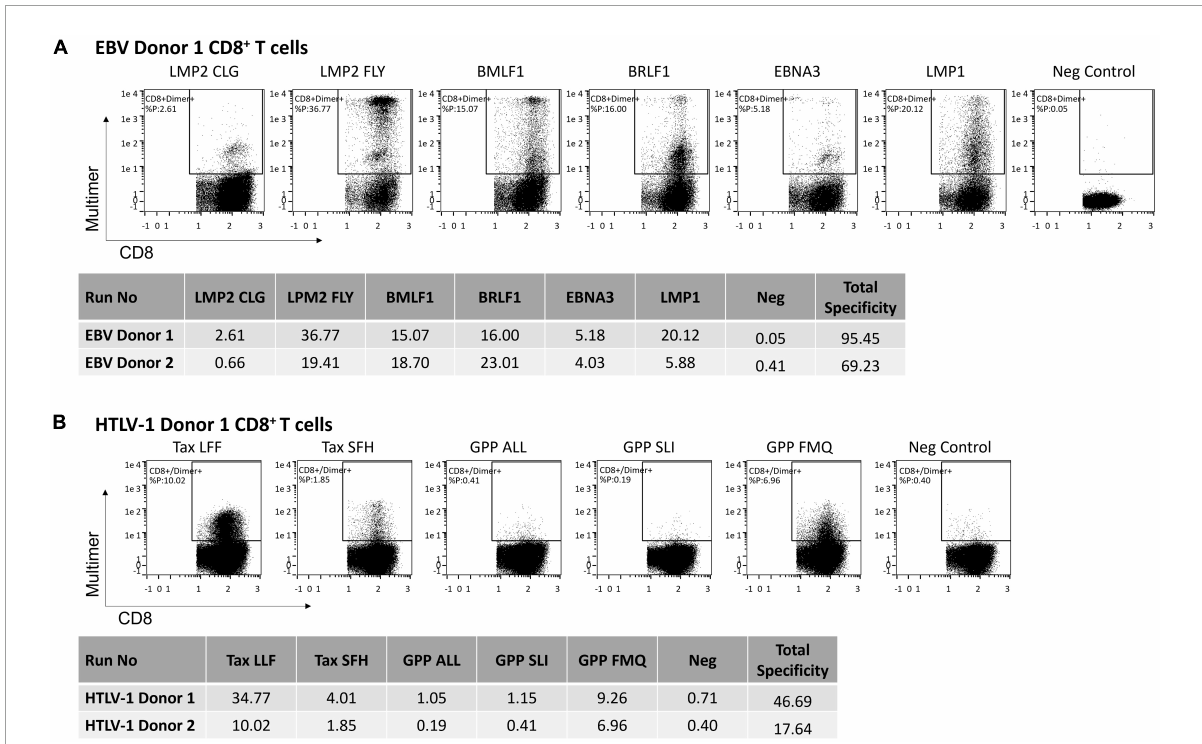
FIGURE2 The frequency of antigen-specific CD8 + T cells among cells enriched and expanded to target HLA-A2 restricted viral peptides. (A) EBV peptides (6 total) or (B) HTLV-1 peptides (5 total) were used to generate E+E cells from two healthy donors. Reported is the frequency of CD8 + T cells that bind peptide-loaded HLA-A2-Ig dimer. Also shown is the total frequency of CD8 + T cells to each of the EBV or HTLV-1 peptides. Total frequency is normalized using an irrelevant peptide, the negative